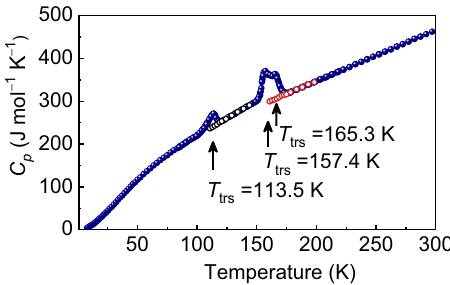
Fig. 2 Temperature dependence of the heat capacity ( C p ) for 1. The molar heat capacities under constant pressure ( C p ) showed two sharp peaks accompanying the latent heat at 113.5 and 157.4 K (there is a shoulder peak at 165.3 K); and exhibited the super-cooling phenomenon. Blue dots, black circles and red circles represent the data obtained during the heating mode after the samples were cooled to 8.0, 110.9, and 160.9 K, respectively.